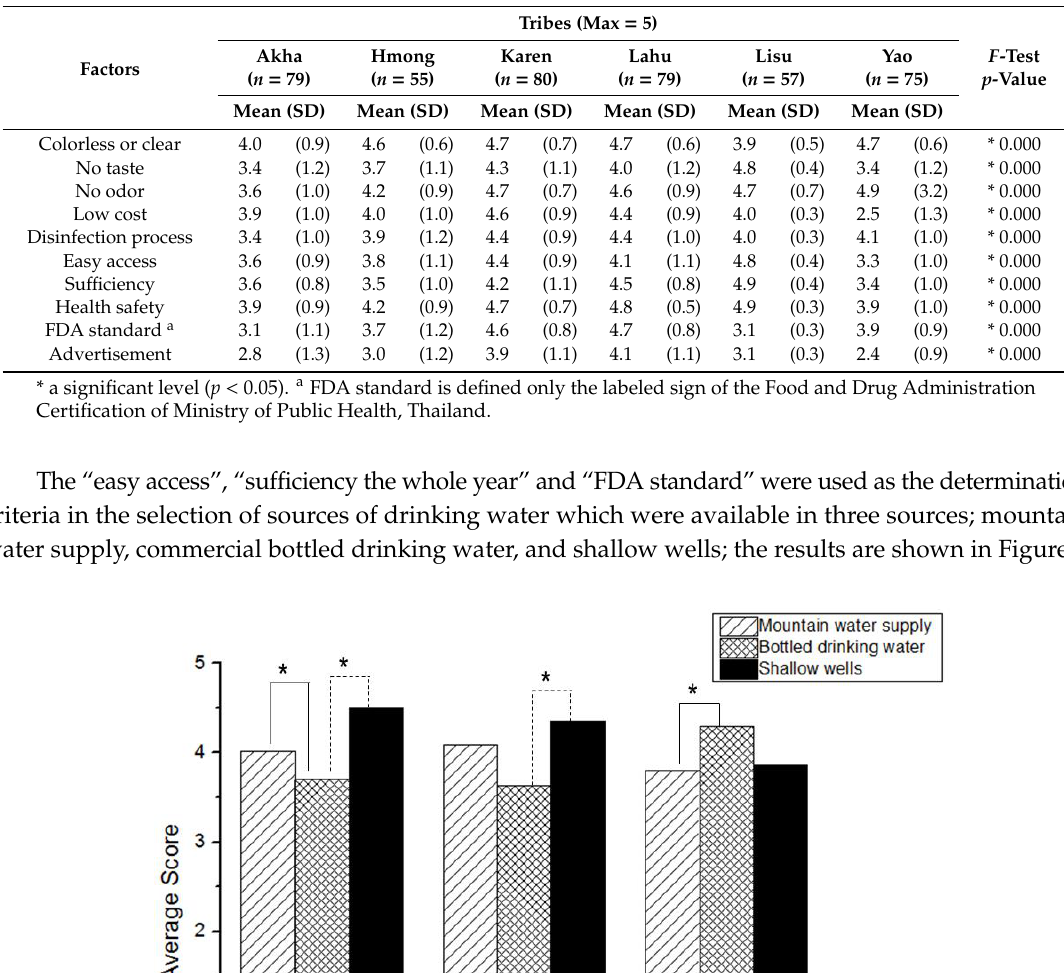
Table 2. Influencing factors in selection of drinking water.